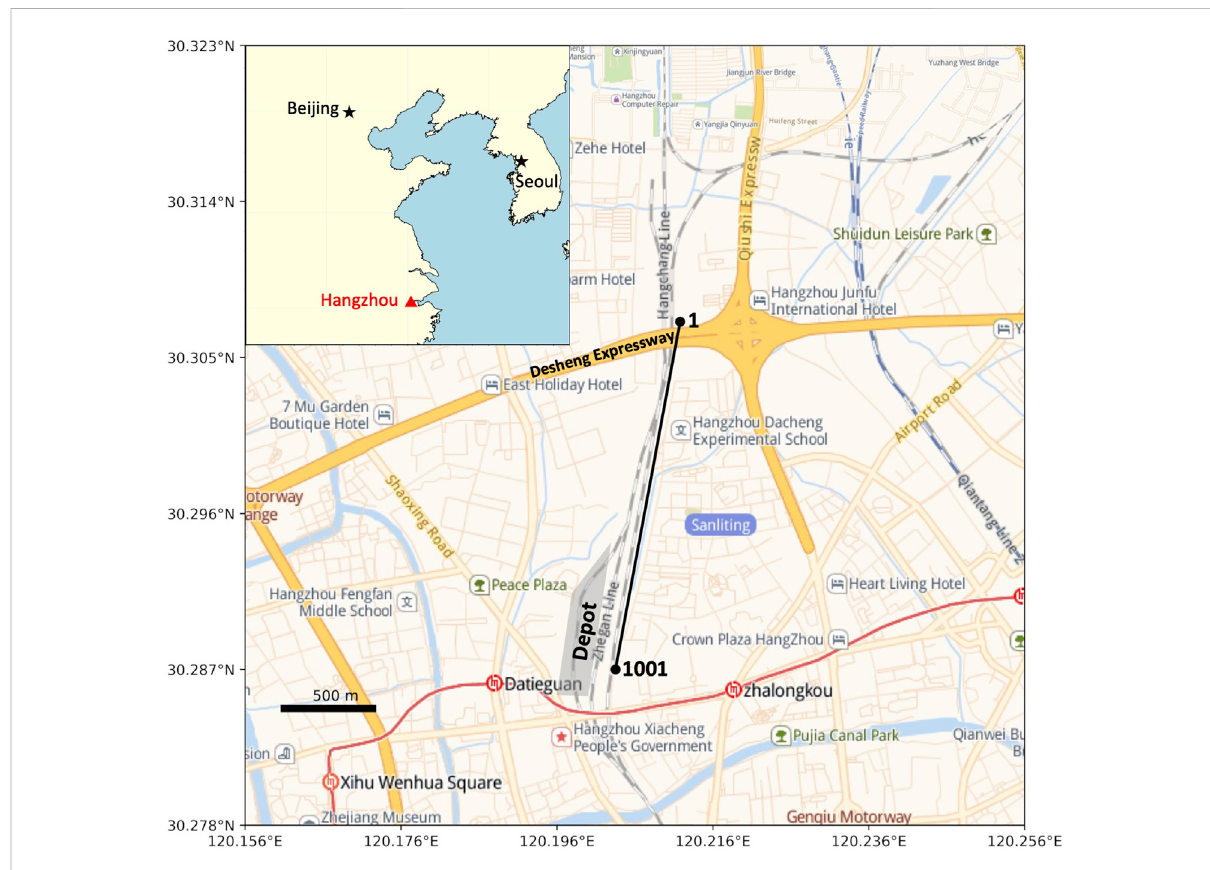
FIGURE 1 Map showing the location of the fi ber-optic cable (black line) 5 km north of Hangzhou station (https://lbs.amap.com/demo/javascript-api/ example/map/map-english/).Greyshade denotes theDepot. The numbers inblackare thestartand end channelnumbers. Thealternatinggrey and white lines are railway roads (Hanghang Line, Zhegan Line). The blue arrow indicates the direction of the train station. The yellow solid lines denote expressways, and Desheng Expressway is marked where the cable segment from channel 1 to channel 200 lies. Hangzhou (red triangle) and other major cities (black star) are also marked on the inset map.